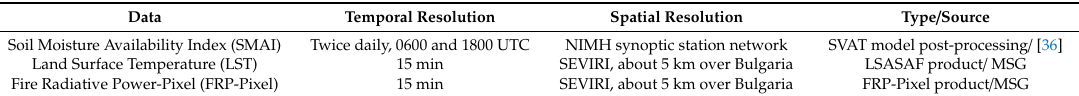
Table 2. Summary of data used and their